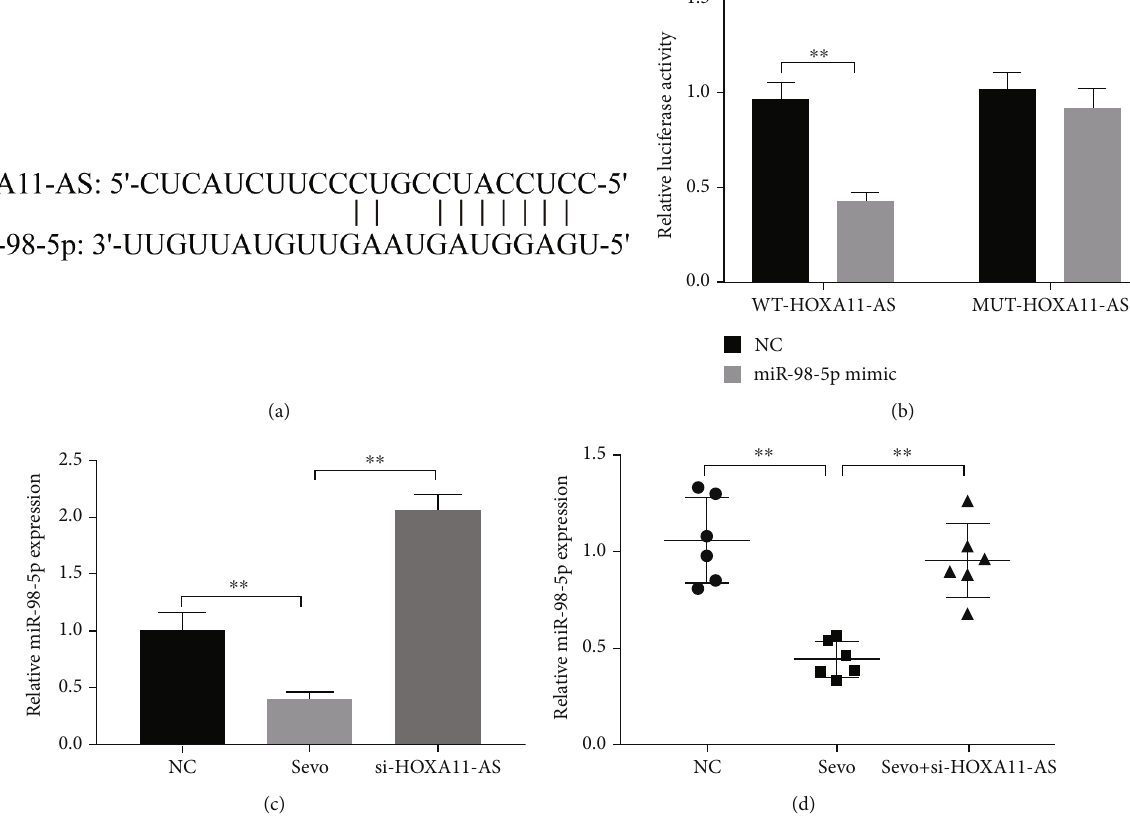
Figure 3: Validation of the correlation between miR-98-5p and HOXA11-AS targeting. (a) Starbase predicts target genes of HOXA11-AS. (b) Dual-luciferase reporter gene veri fi es the targeting relationship. (c, d) RT-qPCR detects miR-98-5p expression in neuronal cells and rat hippocampus. ∗∗ P < 0 : 01